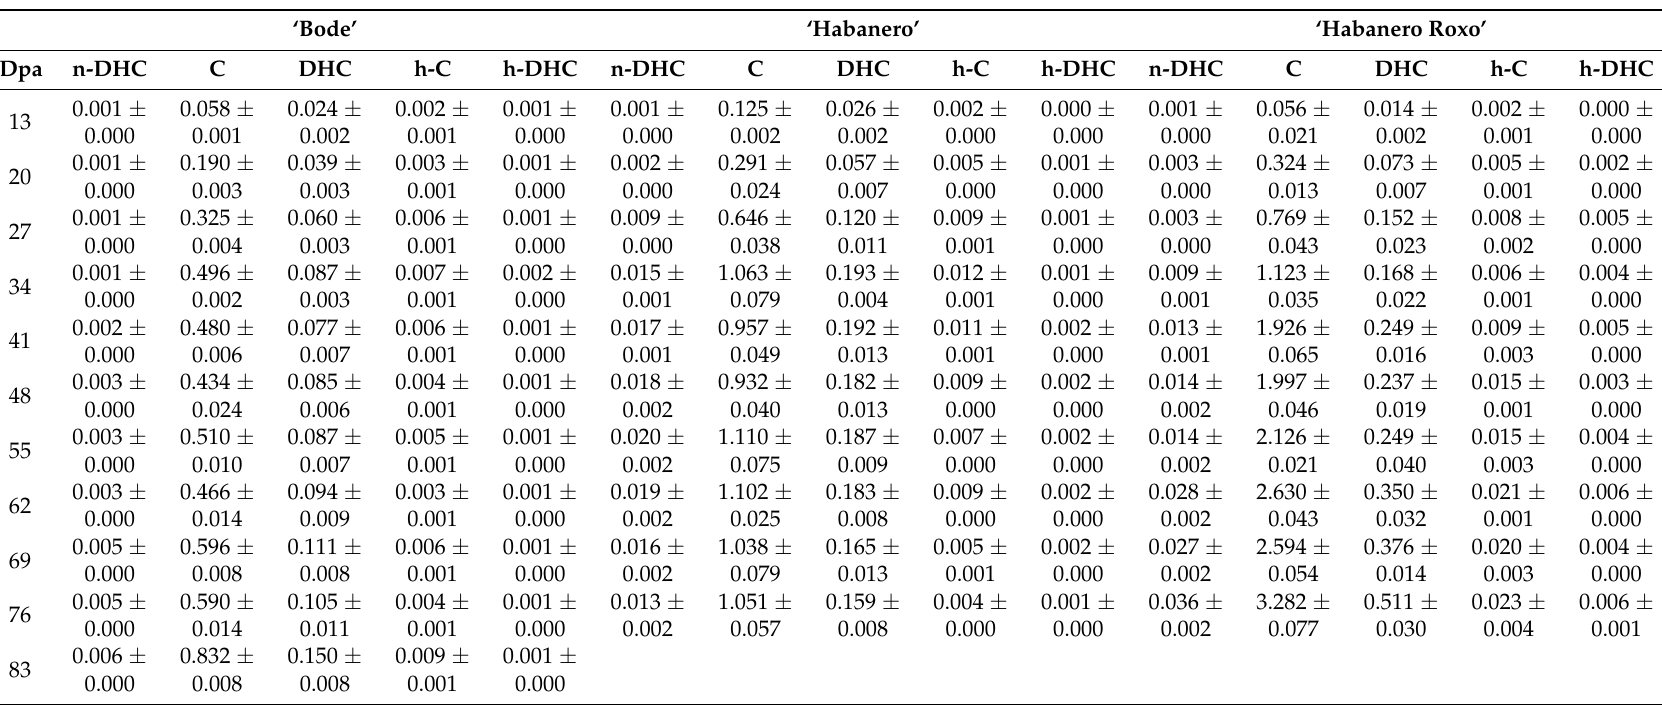
Table 2. Evolution of individual capsaicinoids (nordihydrocapsaicin (n-DHC), capsaicin (C), dihydrocapsaicin (DHC), homocapsaicin (h-C), and